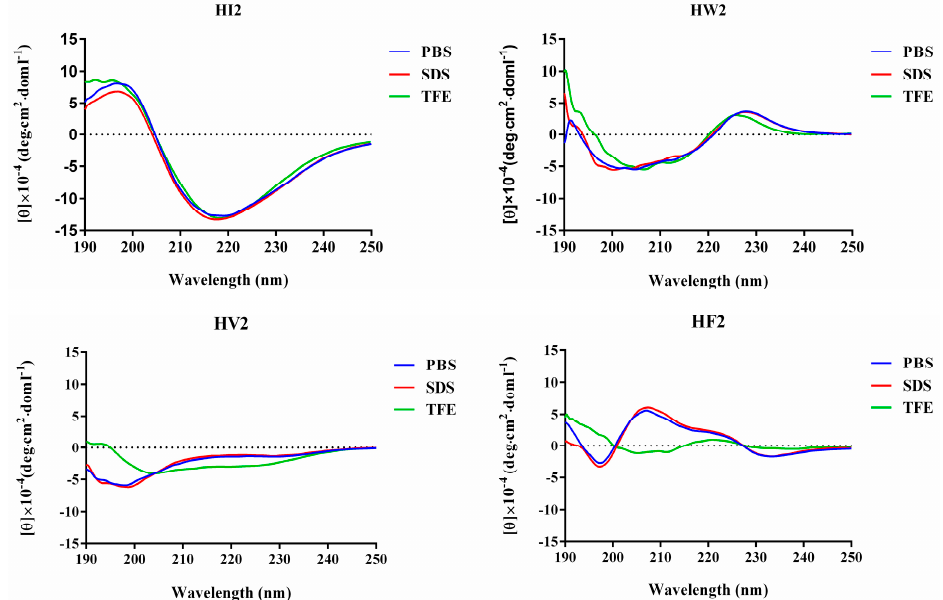
Figure 2. The CD spectra of the peptides. The peptides were dissolved in 10 mM sodium phosphate bu ff er (pH 7.4) (Blue line), 30 mM SDS (Red line) and 50% TFE (Green line). The mean residue ellipticity was plotted against wavelength. The values from three scans were averaged per sample, and the peptides concentrations were fixed at 150 µ M. Table 2. MIC, MHC and TI of the